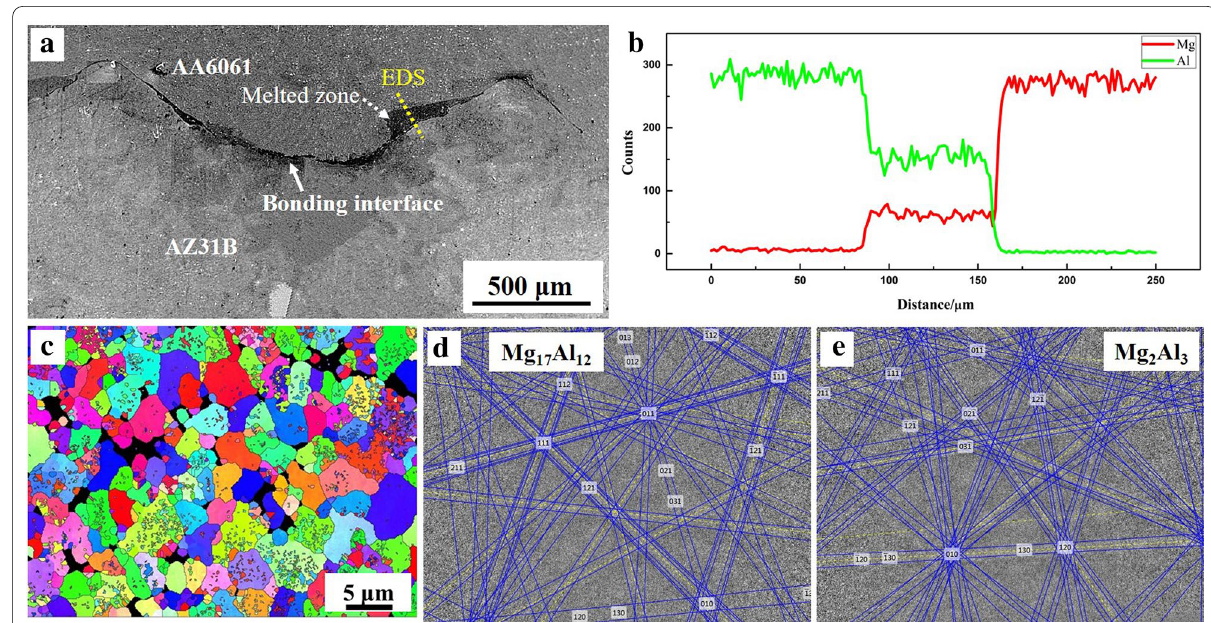
Figure 3 Typical sine wave interface with melted zones of AA6061/AZ31B explosive welded clad plate: ( a ) BSE image of the bonding interface; ( b ) EDS line scanning across the melted zone; ( c ) ‒ ( e ) EBSD results at the melted